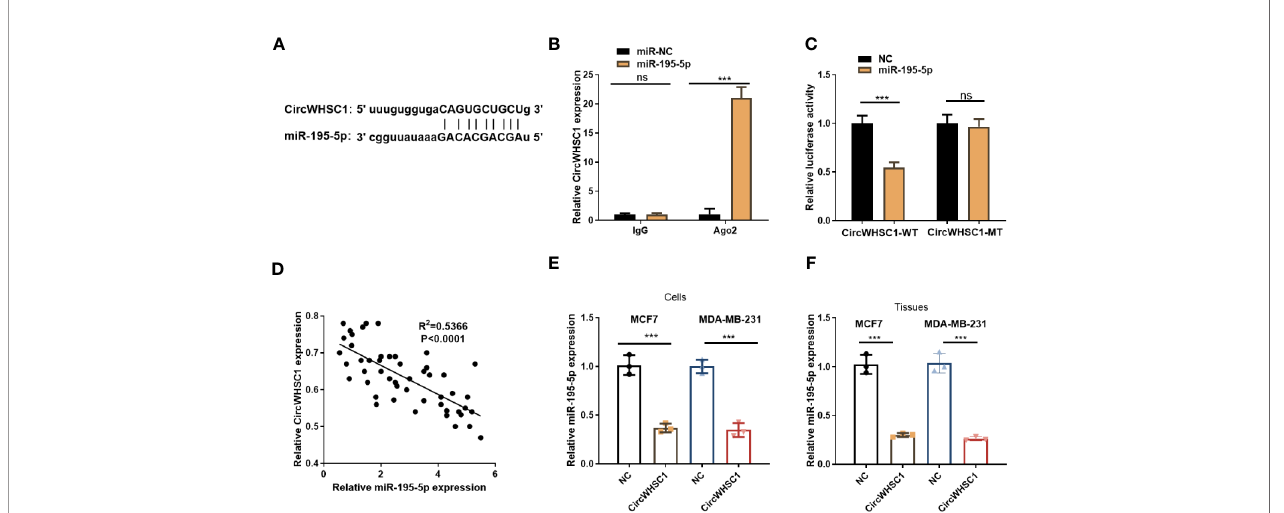
FIGURE 4 | CircWHSC1 targeted and abated miR-195-5p level. (A) The binding sites between circWHSC1 and miR-195-5p were analyzed by Starbase. (B) RIP assay was performed for verifying the binding between circWHSC1 and miR-195-5p. The enrichment of circWHSC1 in the lysates was determined by qRT-PCR. (C) The dual-luciferase reporter gene assay veri fi ed the binding correlation between circWHSC1 and miR-195-5p. (D) Pearson linear regression analysis checked circWHSC1 and miR-195-5p expression in BC tissues. (E, F) miR-195-5p expression in MCF7 and MDA-MB-231 cells transfected with NC or circWHSC1 overexpression plasmids (E) or in xenograft tumors formed by MCF7 and MDA-MB-231 cells (with NC or circWHSC1 overexpression plasmids transfection) (F) was evaluated by qRT-PCR. ns P > 0.05, * P < 0.05, ** P < 0.01, *** P < 0.001 (vs. NC group).